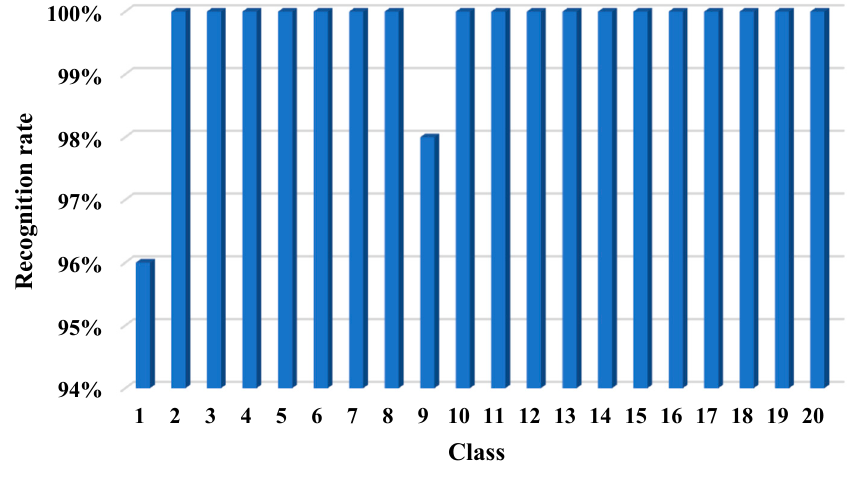
Figure 21. The result of the comprehensive test.